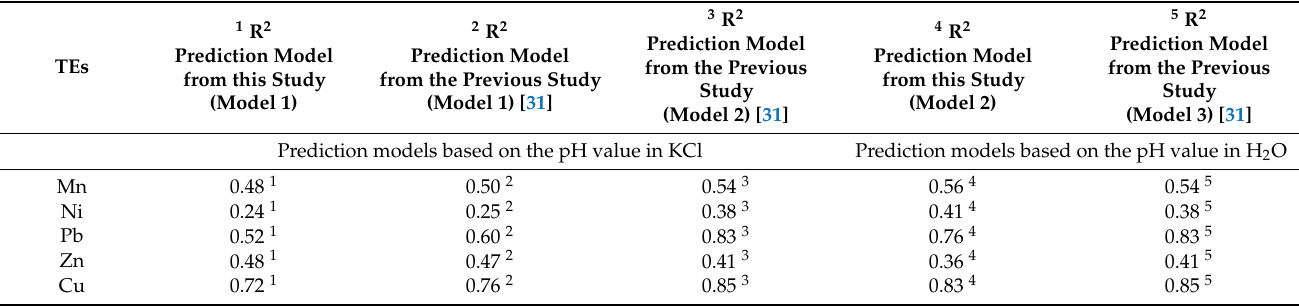
Table 5. Reliability of prediction models expressed by the coefficient of determination (R 2 ) for TEs from this and previous study. 1 R 2 TEs